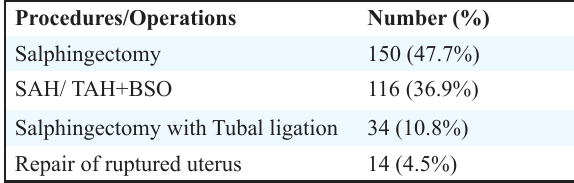
Table 3. Emergency procedures/operations performed on the